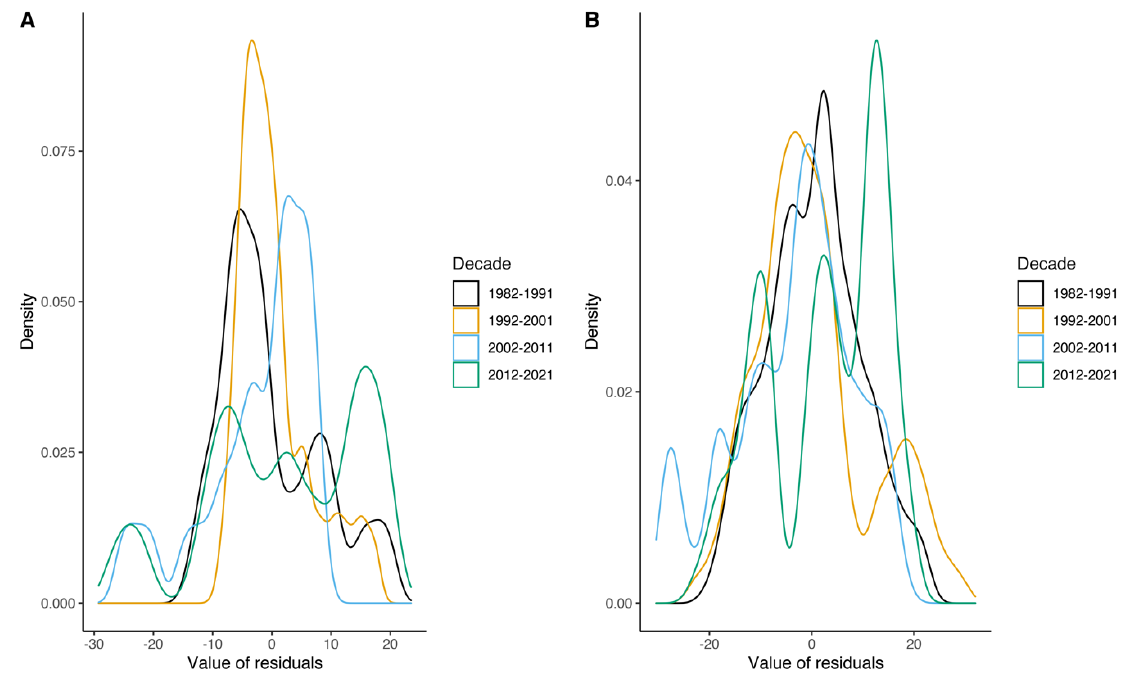
Figure S3. Distribution of the residuals of the 1000 piecewise regression on start of the breeding season (A) and peak breeding (B) . We divided the residuals in four different decades: decade 1 (1982-1991), decade 2 (1992-2001), decade 3 (2002-2011) and decade 4